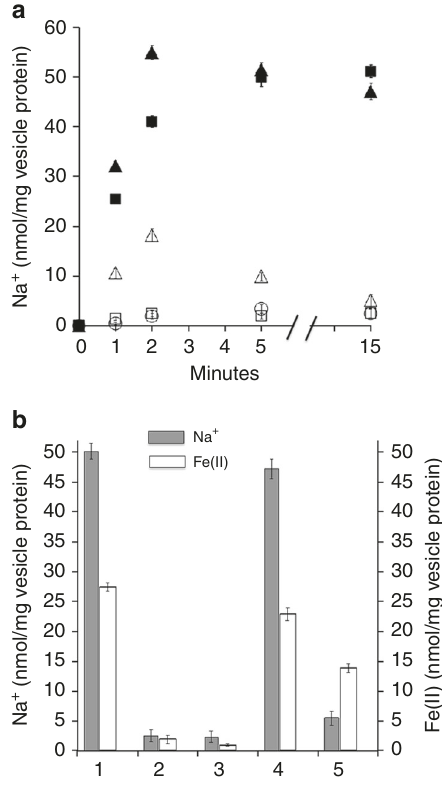
Fig. 2 Accumulation of 22 Na + in the lumen of everted membrane vesicles dependent on ferredoxin:Fe(III) oxidoreductase activity. The standard reaction mixture (1.0 ml) contained Fe(III)-loaded vesicles (1.0 mg protein) from acetate-grown cells, 5.0 μ M Fdx (ferredoxin), 0.5mM NaCl, 0.5 μ Ci/ ml 22 NaCl (carrier free), 25mM MgSO 4 , 0.4M sucrose and 10 mM dithiothreitol in 50mM Tris (pH 8.0) and 1.0atmosphere of CO. Reactions were initiated by addition of CO dehydrogenase/acetyl-CoA synthase (0.1 mg). a Time course of accumulation. Data points are the mean of three biological replicates for which the standard deviation is shown by error bars. Standard reaction mixture ( fi lled squares), minus Fdx (empty squares), with empty vesicles (empty circles), plus 10 µ M carbonyl cyanide m -chlorophenyl hydrazine (CCCP) ( fi lled triangles), plus 10 μ M ETH157 (empty triangles). No accumulation occurred if N 2 replaced CO. b Sodium and Fe(II) accumulation in the lumen of vesicles at the 15-min time point shown in a . The standard reaction mixtures were modi fi ed as indicated for each bar: (1) standard, no modi fi cation, (2) minus Fdx, (3) empty vesicles, (4) plus 10 μ M CCCP, (5) plus 10 μ M ETH157. Bars are the mean of three biological replicates for which the standard deviation is shown by error bars